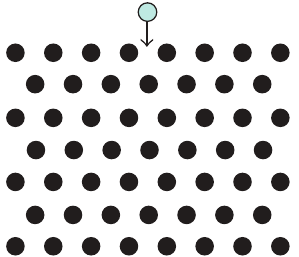
Figure 7: A vertical peg board with stationary pegs (black circles). A blue disk falls and scatters through the lattice of pegs, analagous to electrons scattering off ions as they move through a wire, leading to resistivity.